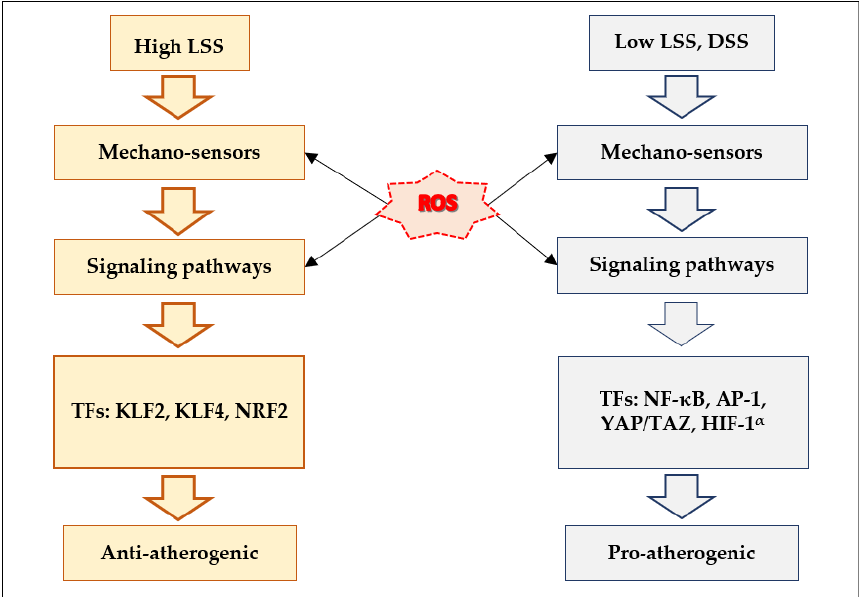
Figure 6. Scheme illustrating the potential influence of ROS on shear-stress-induced activation of transcription factors involved in anti-atherogenic and pro-atherogenic responses. LSS: laminar shear stress; DSS: disturbed shear stress; and TFs: transcription factors.